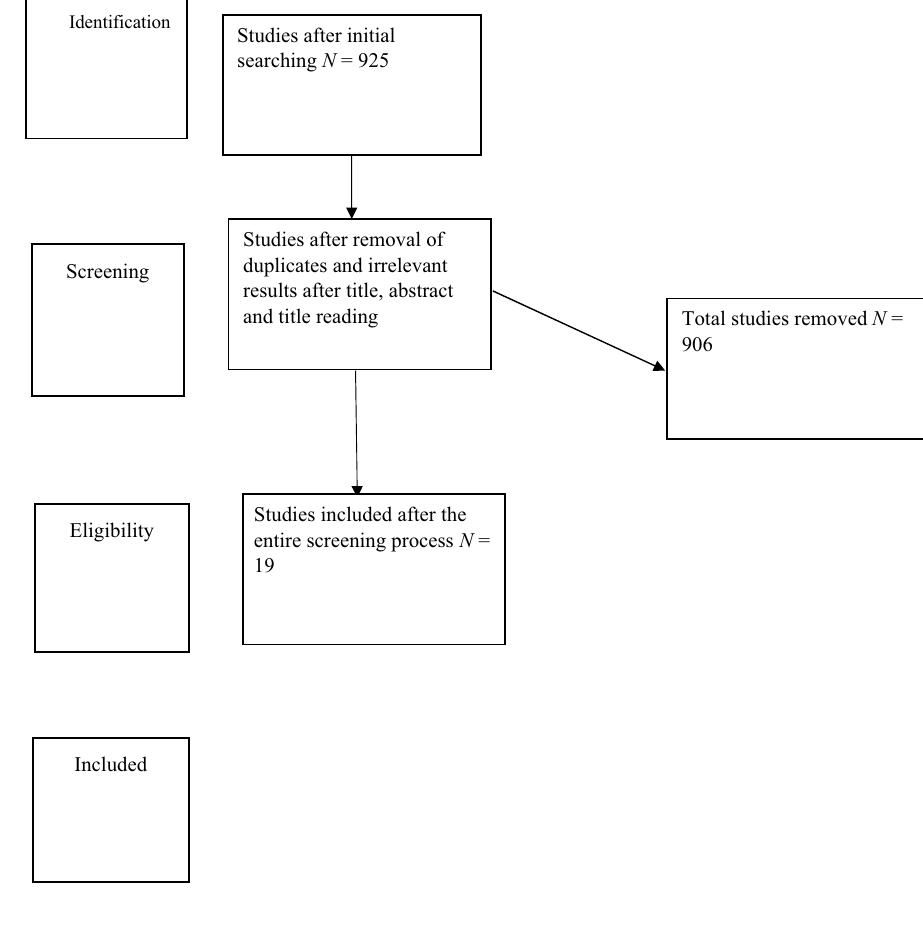
Fig. 1 Flowchart figure